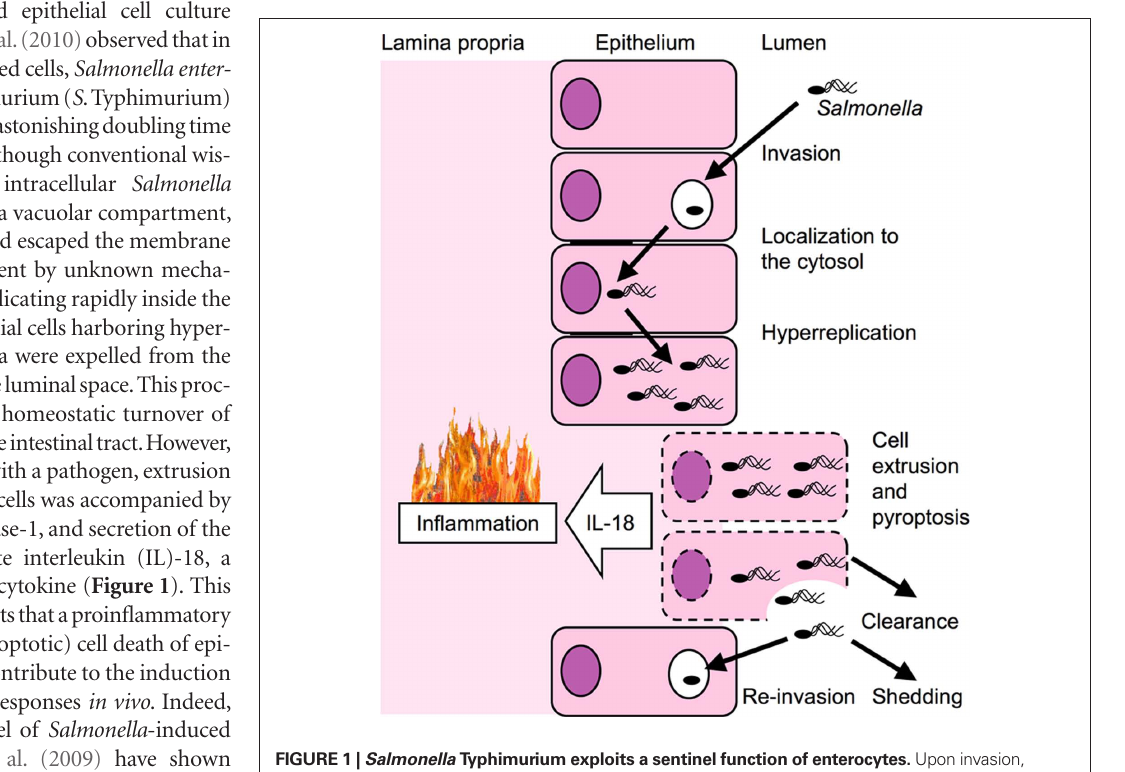
Figure 1 | Salmonella Typhimurium exploits a sentinel function of enterocytes. Upon invasion, S. Typhimurium escapes into the cytosol in a fraction of epithelial cells, thereby triggering proinflammatory cell death (pyroptosis). Extrusion of pyroptotic epithelial cells into the lumen releases S. Typhimurium primed for epithelial invasion. For further explanation see